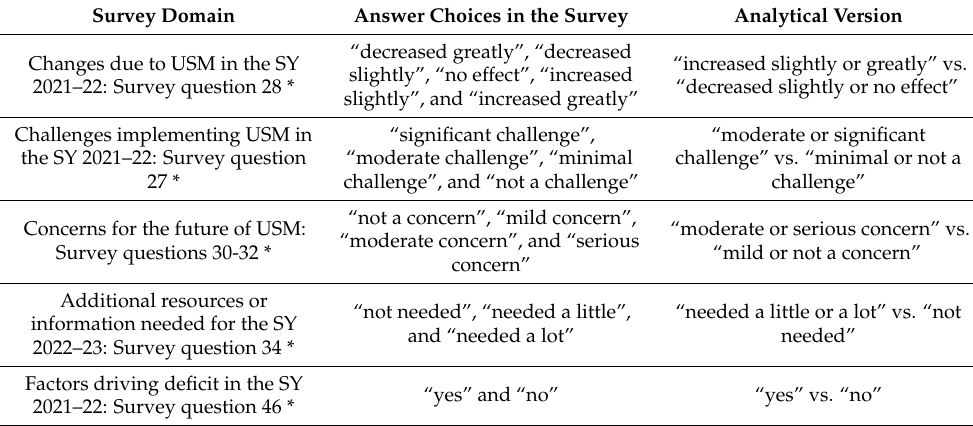
Table 1. Description of original and operational version of the variables.